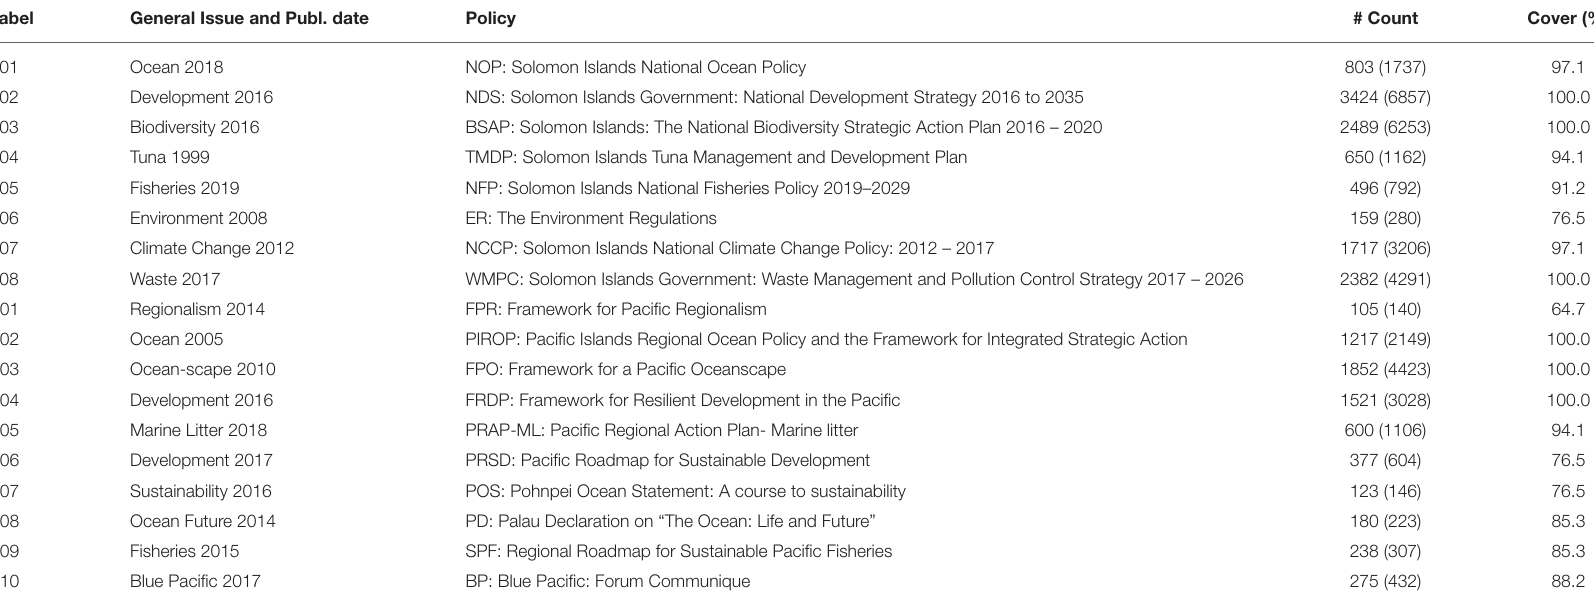
Labels beginning with an “S” (respectively an “R”) refer to policies of the Solomon Islands (respectively of the Pacific Region). Count column indicates the number of selected distinct expressions extracted from the policy text (in parenthesis: raw number of selected expressions, with duplicates). Last column gives the % of the 34 themes covered by the